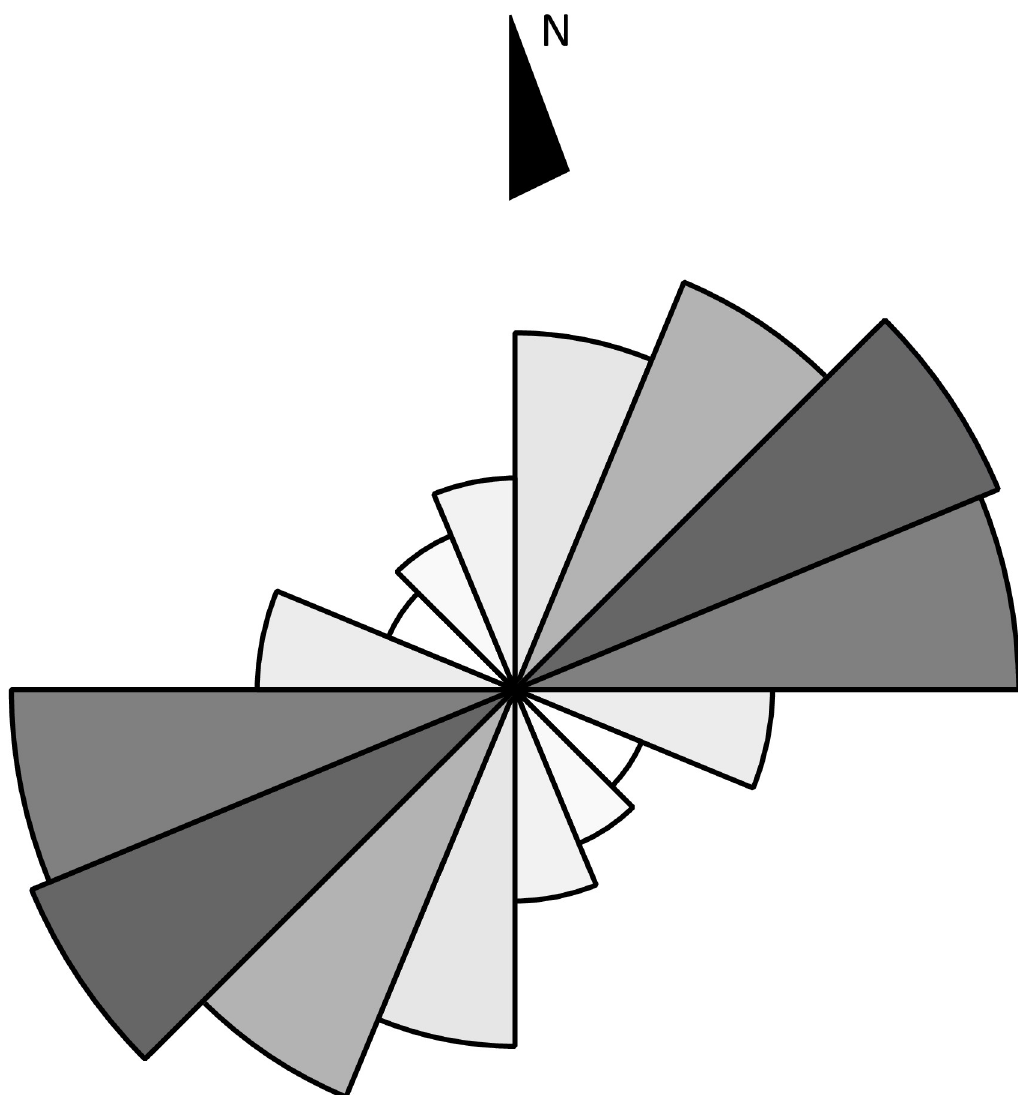
Fig 12. Rose-chart showing the directional tendency of qanats